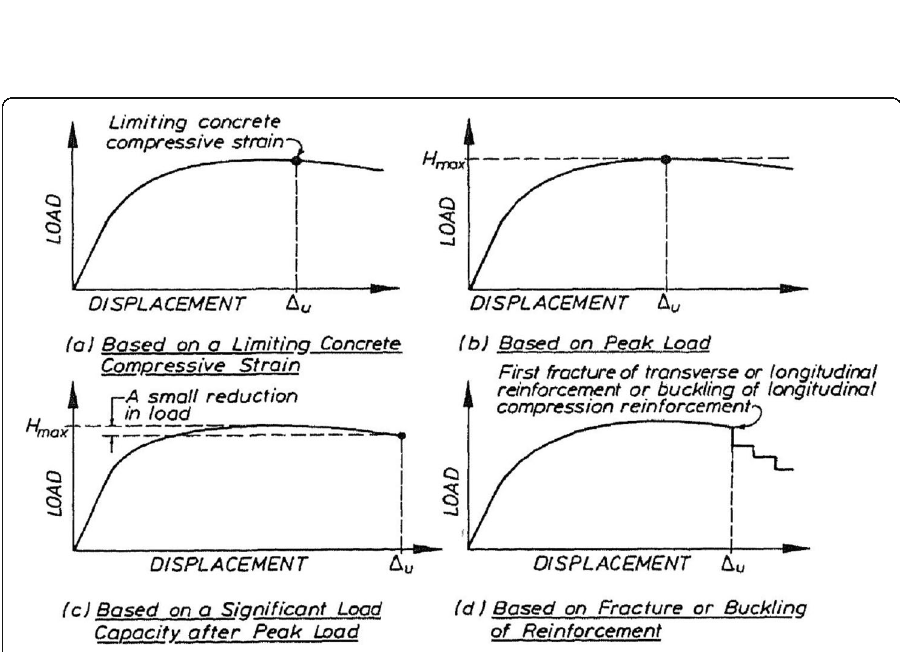
Fig. 18 Alternative definition for ultimate displacement